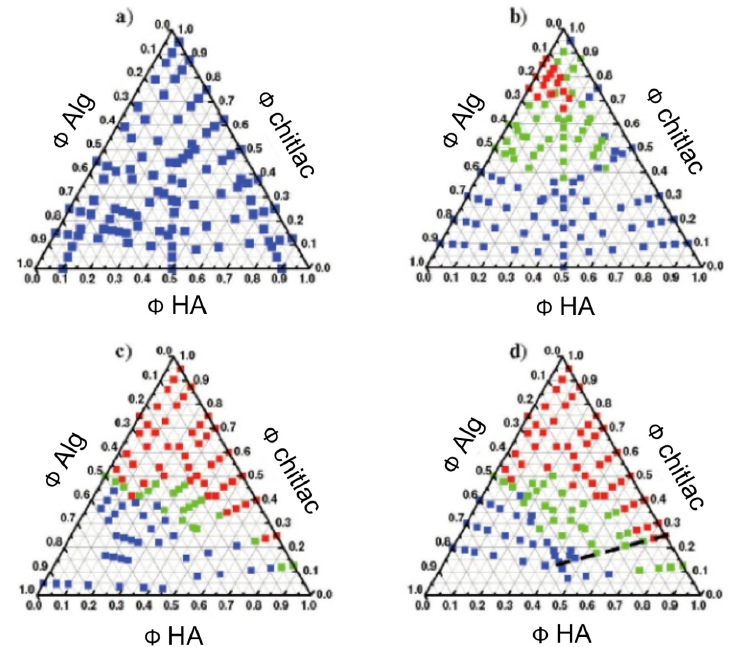
Figure 5. Miscibility of ternary mixtures of alginate (Alg), hyaluronan (HA), and lactose-modified chitosan (chitlac) in aqueous a ) NaCl 0.15 M; b ) NaCl 0.075 M; c ) NaCl 0.015 with a total polymer chitosan (chitlac) in aqueous ( a ) NaCl 0.15 M; ( b ) NaCl 0.075 M; ( c ) NaCl 0.015 with a total